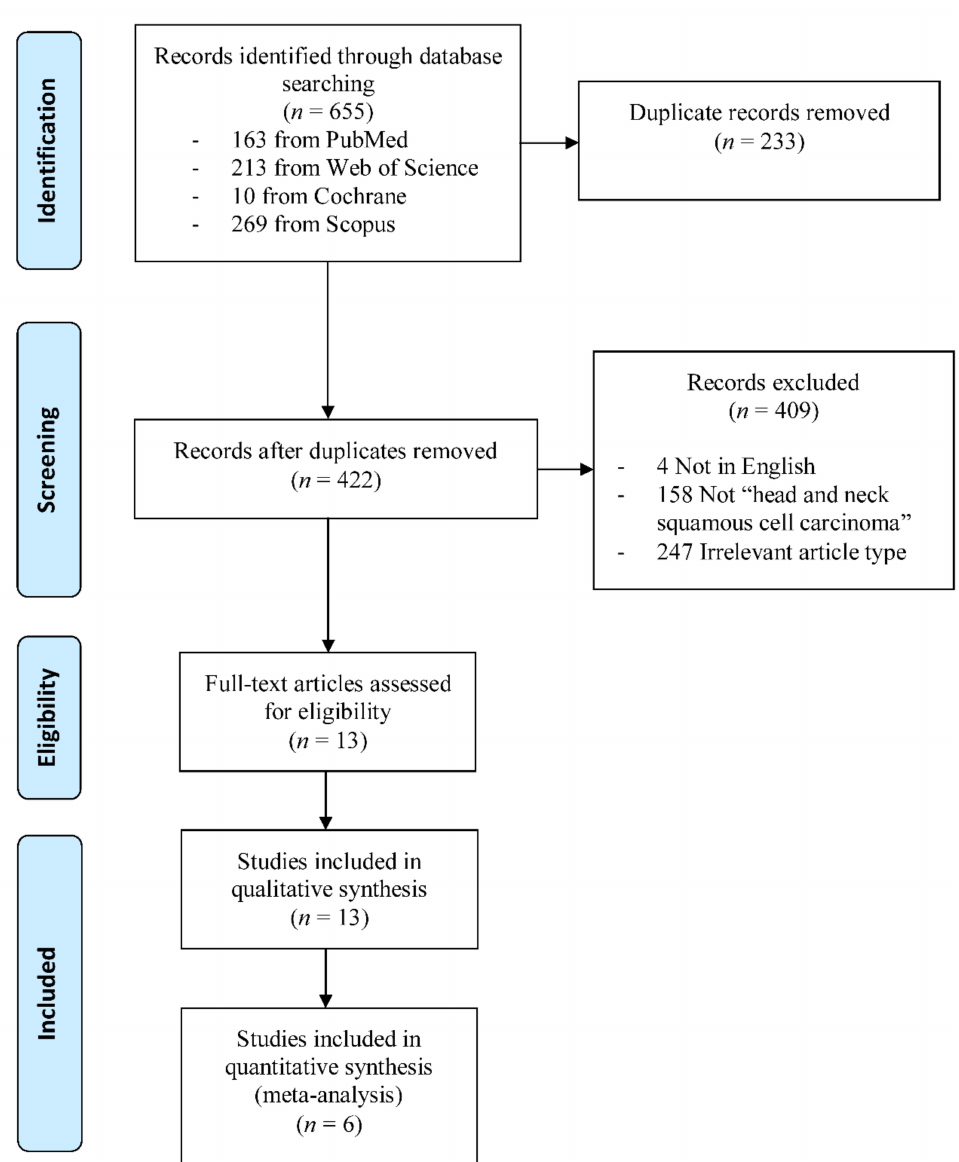
Figure 1. Flowchart diagram of the literature search and selection